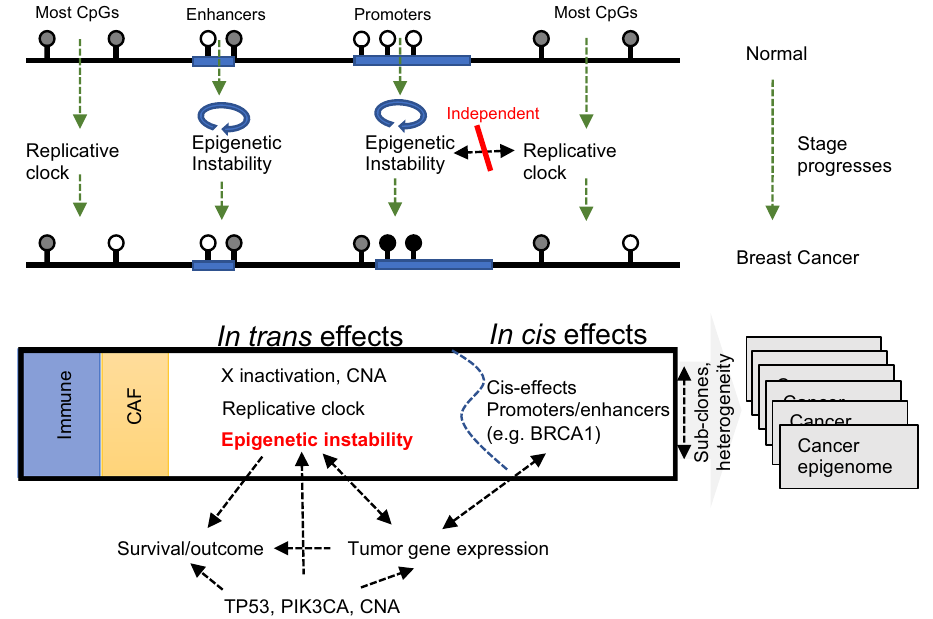
Fig. 5 Uni fi ed model delineating the multi-factorial processes giving rise to breast cancer DNA methylation. As the carcinogenesis process progresses (top), epigenomes are affected by replication-dependent methylation loss in most of the genome, and by a second, uncorrelated epigenetic instability process modulating methylation in promoters and enhancers. When cancer epigenomes are surveyed (middle), the observed pro fi les involve a superposition of TME signatures, with the patient-speci fi c replication and instability signatures, and with epigenetic dosage compensation. These processes are each affecting a large number of genomic loci through one common mechanism ( in trans effects). Additional localized patient-speci fi c methylation aberrations are uncorrelated with these in trans effects and may regulate gene expression in cis . Deconvolution of these multi-layered effects shows linkage between epigenetic instability and disease stage and prognosis (bottom). Cancer epigenomic heterogeneity is also induced by cellular heterogeneity (such as clonal